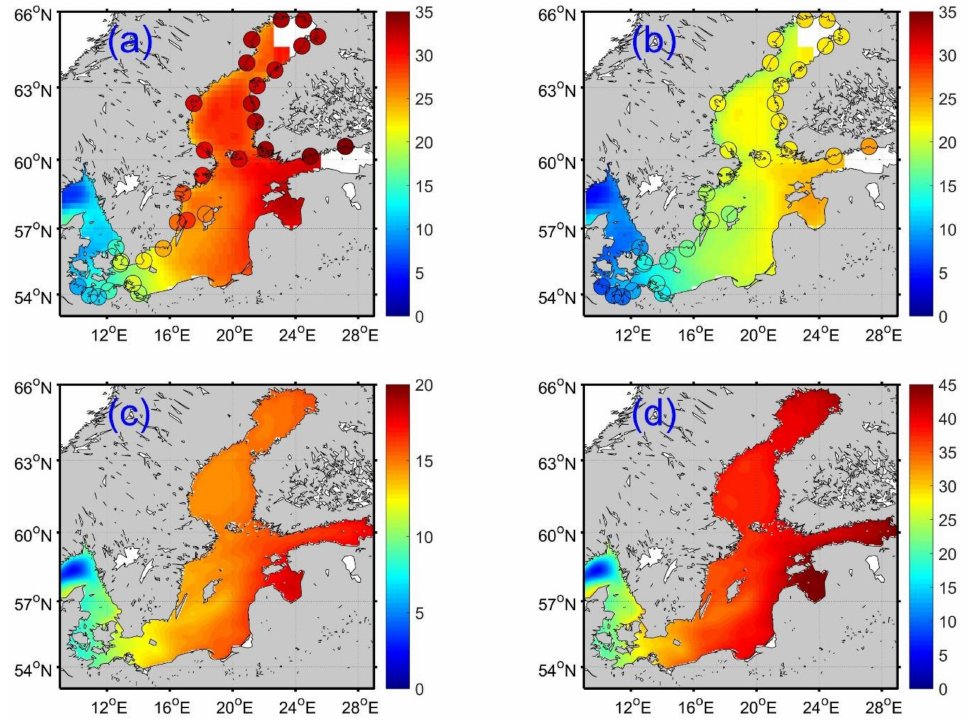
Figure 6. Geographical distribution of the maximum ( a , c ) and minimum (multiplied by − 1, b , d ) annual sea level (cm) estimated from satellite altimetry and tide gauge data ( a , b ) and SMHI model reanalysis ( c , d ) the time period